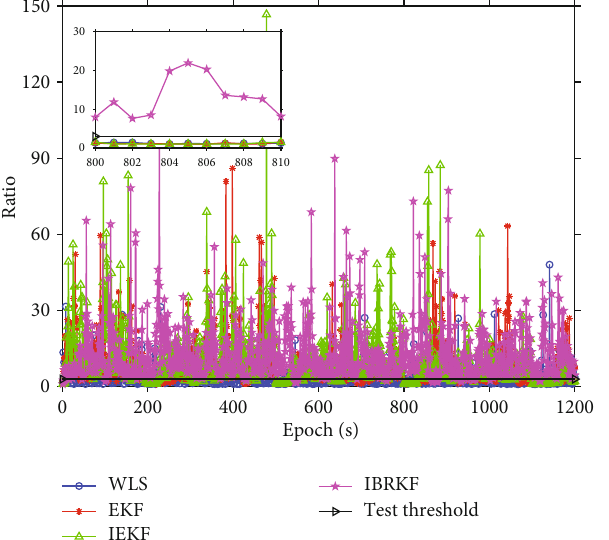
Figure 9: The ratio values of WLS, EKF, IEKF, and IBRKF (Data